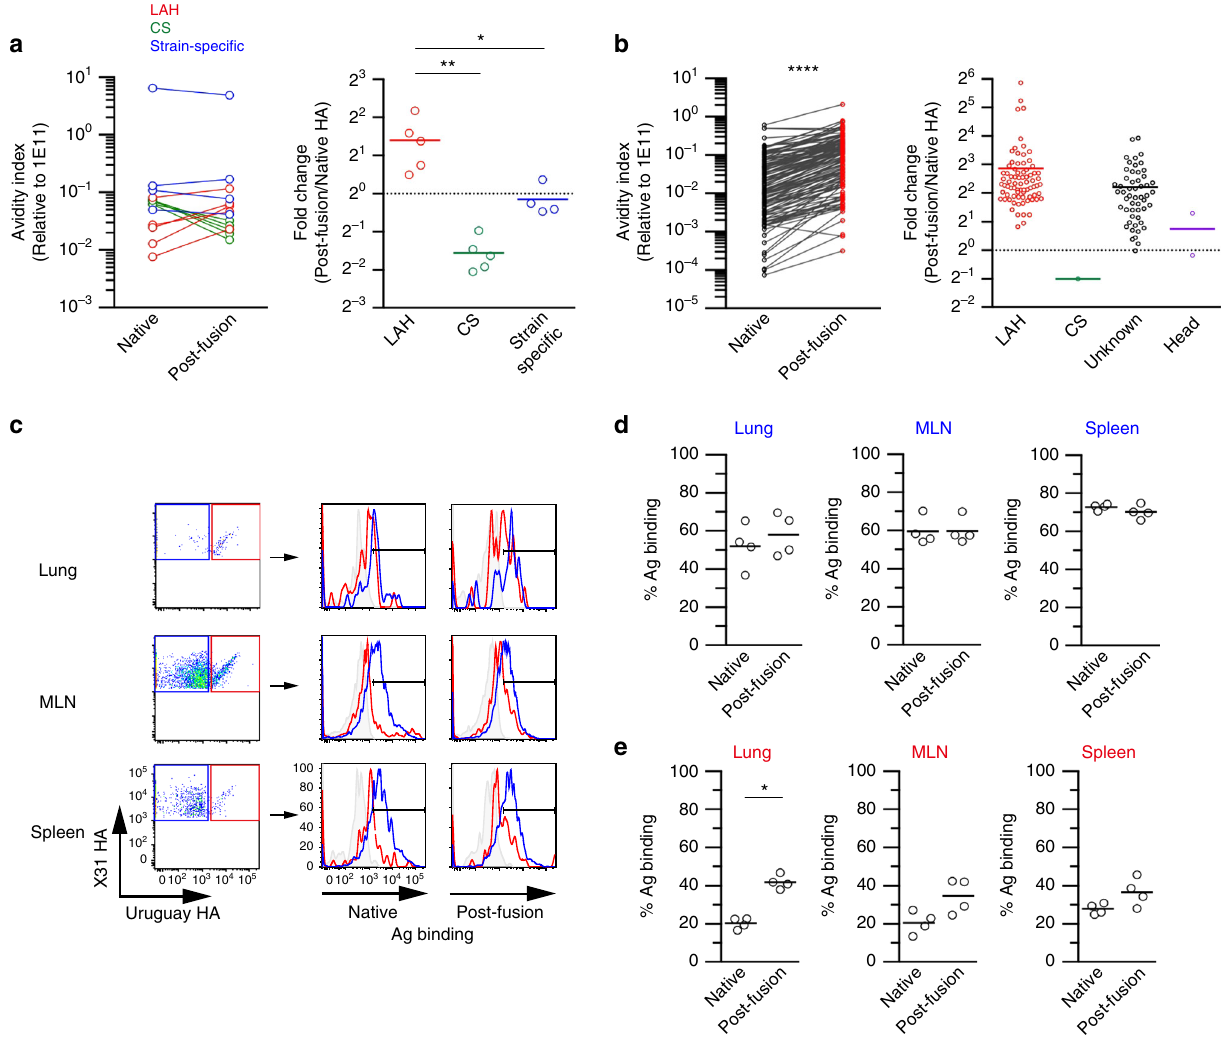
Fig. 4 LAH epitope is exposed in post-fusion HA antigen. a HA-split antigen (X31) was converted into post-fusion form by treating at pH 5.0. Avidity index toward native and post-fusion HA antigens were determined from puri fi ed mAbs (LAH; 5 clones, CS; 5 clones, strain-speci fi c; 4 clones) using strain- speci fi c 1E11 clone as reference. Fold change was calculated by avidity index and comparably plotted from the three groups. Each dot represents the result from individual mAb clone. b Avidity index toward native and post-fusion HA antigens and fold change were plotted using the same supernatants from cross-reactive GC B cells in the lungs. c Cross-reactive and strain-speci fi c GC B cells were gated, and the percentages of cells binding to native and post- fusion HA antigens that were labeled with fl uorochromes were assessed by fl ow cytometry. Control histogram (gray fi lled); Narita HA-binding GC B cells of Narita virus-infected mice. d , e The percentages of strain-speci fi c d and cross-reactive cells e binding to native and post-fusion HA antigens were plotted. Each circle represents the result from an individual mouse. The representative data from two independent experiments are shown. The P -values were determined with a two-tailed Mann – Whitney test ( a , e ) and Wilcoxon matched-pairs signed rank test b . * P < 0.05; ** P < 0.01; **** P < 0.0001. Source data are provided as a Source Data fi